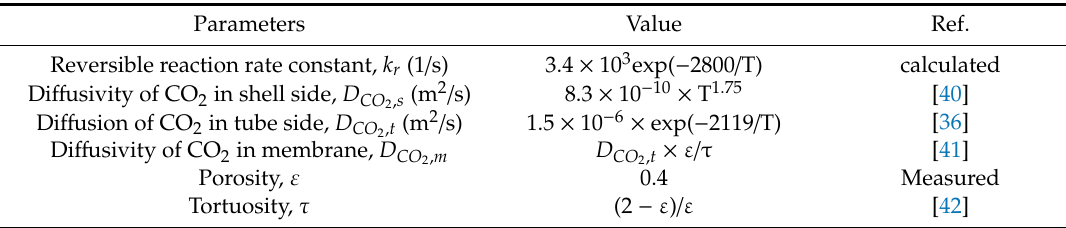
Table 2. Parameters of the process.